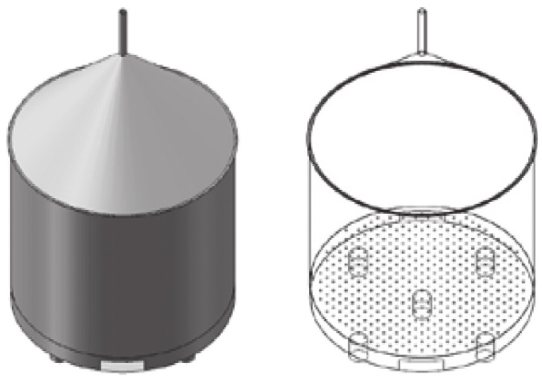
Figure 4: Production of carboniser/charcoal kiln.